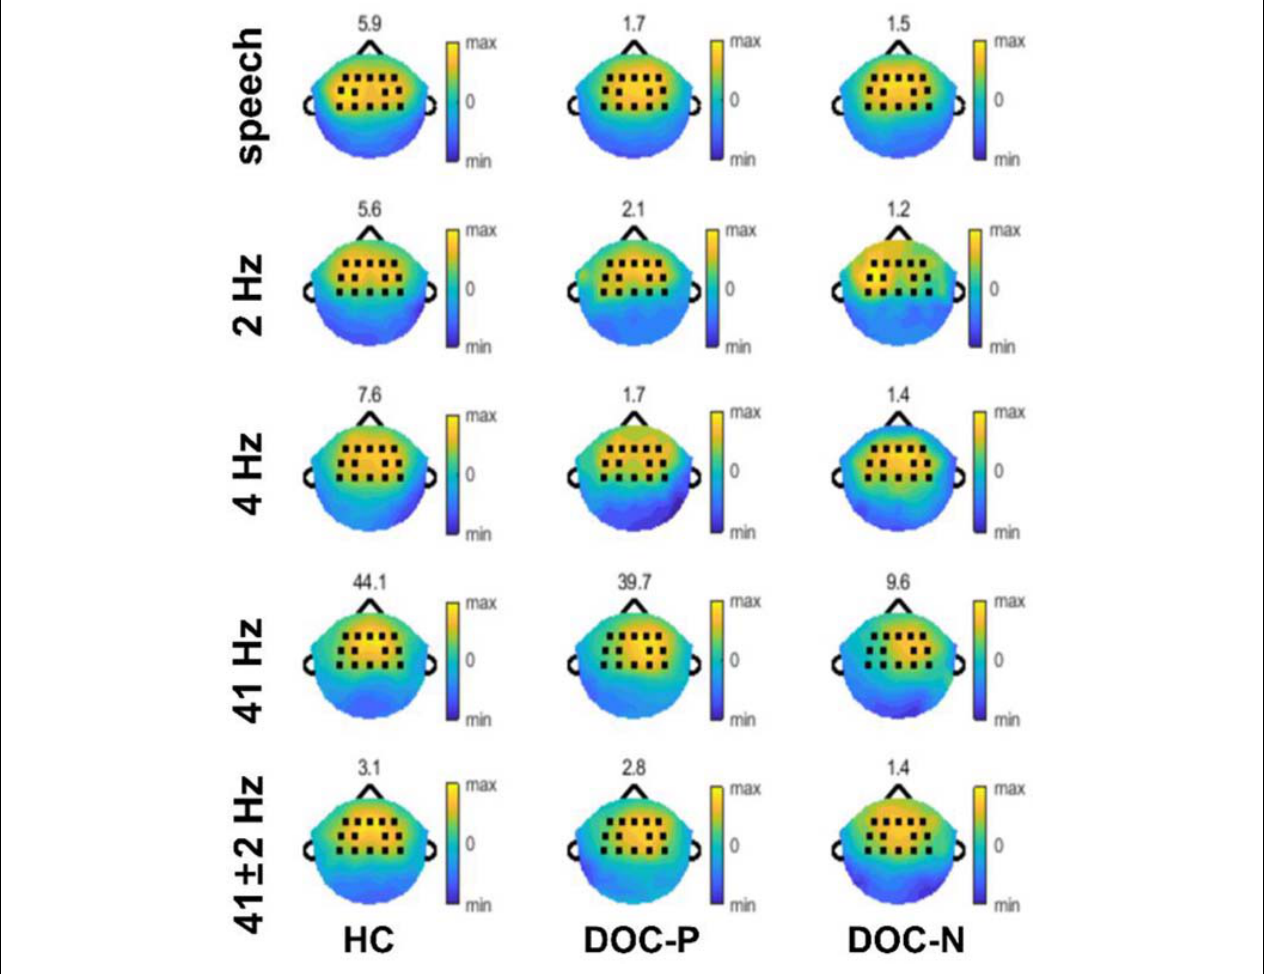
FIGURE 2 | Topography of phase coherence. Phase coherence was separately normalized for each population by dividing by the 95th percentile of phase coherence across electrodes, to accurately illustrate the spatial distribution, and the values of the 95th percentile are shown on top of each